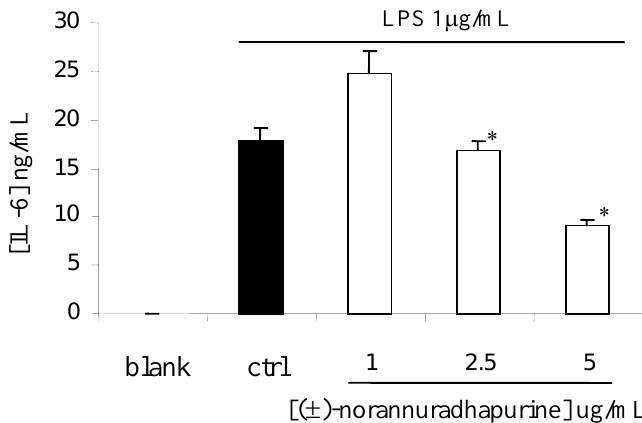
Figure 7 . Effect of (±)-norannuradhapurine on LPS induced IL-6 production by RAW 264.7 cells. The values are the means of at least three determinations ± SD.